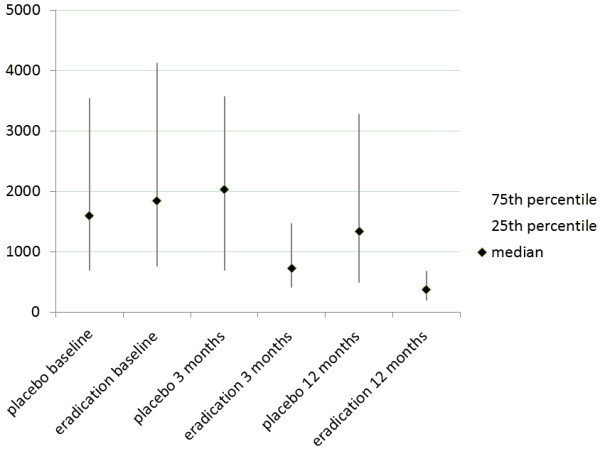
Median (black diamond) and interquartile range (grey line) of H. pylori IgG-antibody titers in IU/mL for the eradication and placebo groups, at baseline, 3 months and 12 months after eradication therapy.